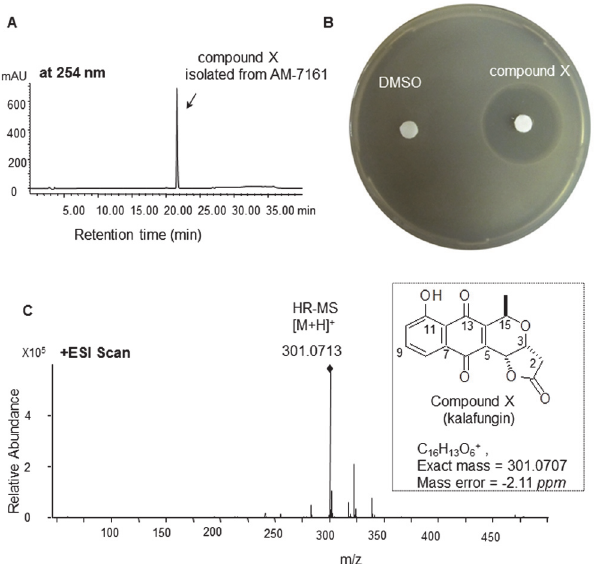
Fig 4. Purification and structural elucidation of compound X isolated from AM-7161. Absorption profile at 254 nm (A, HPLC analysis), bioassay (B, DMSO as blank control), and high resolution mass spectrum (C) of compound X purified from AM-7161 are